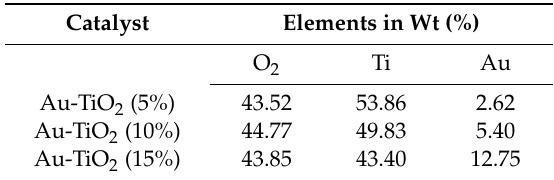
Table 1. Elemental composition of the catalysts doped with gold particles by weight percentage deposited on TiO 2 P-25 catalyst and determined by